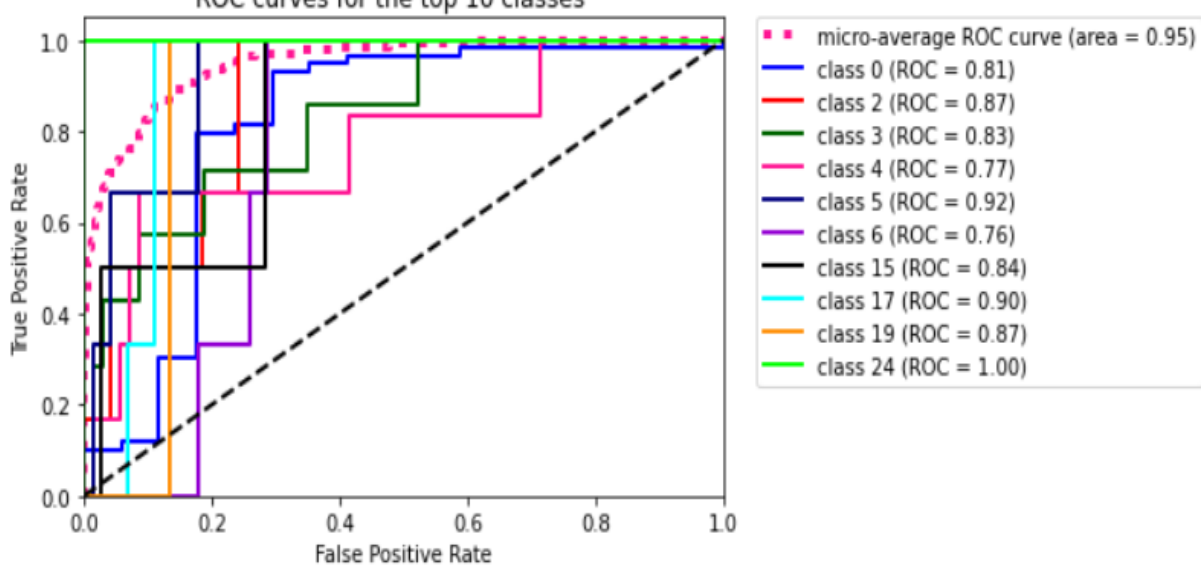
Figure 8. The ROC curves of the proposed ML-CNN